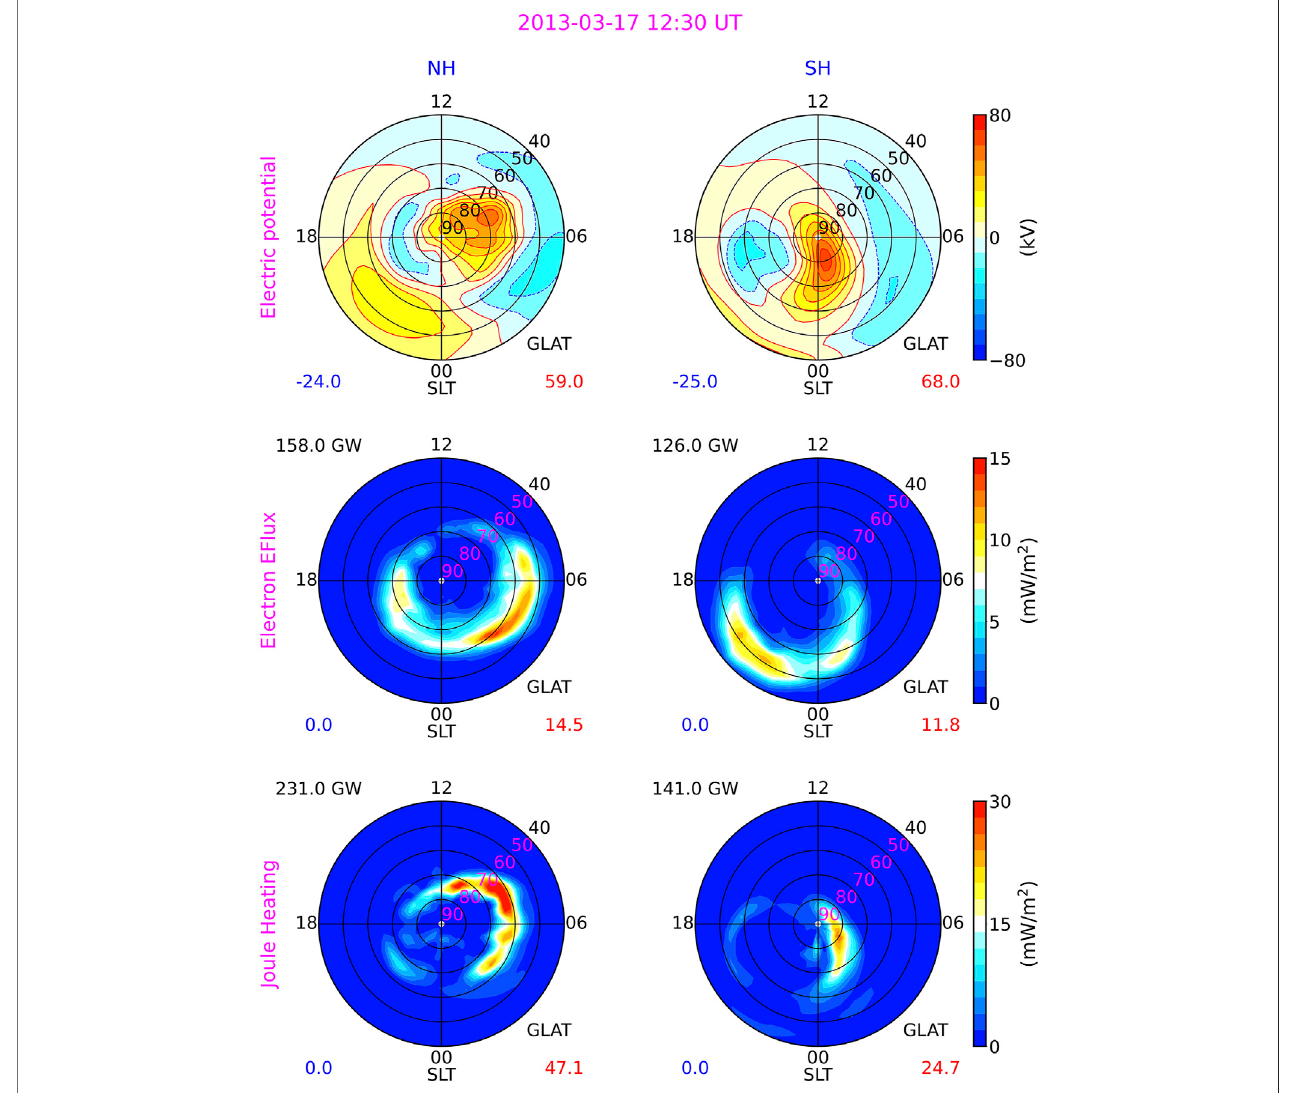
FIGURE8| Distributionsofthe(top)electricpotential,(middle)totalelectronenergy fl uxand(bottom)height-integratedJouleheatinginthe(left)NHand(right)SHat 12:30 UTon03/17/2013.Theminimumand maximum ineachplotarelabelledat thebottomleftand right ofeach plot,respectively.Thevalueatthetopleftofeach plot in the bottom two rows represents the hemispheric integrated value. All plots are present in geographic coordinates.